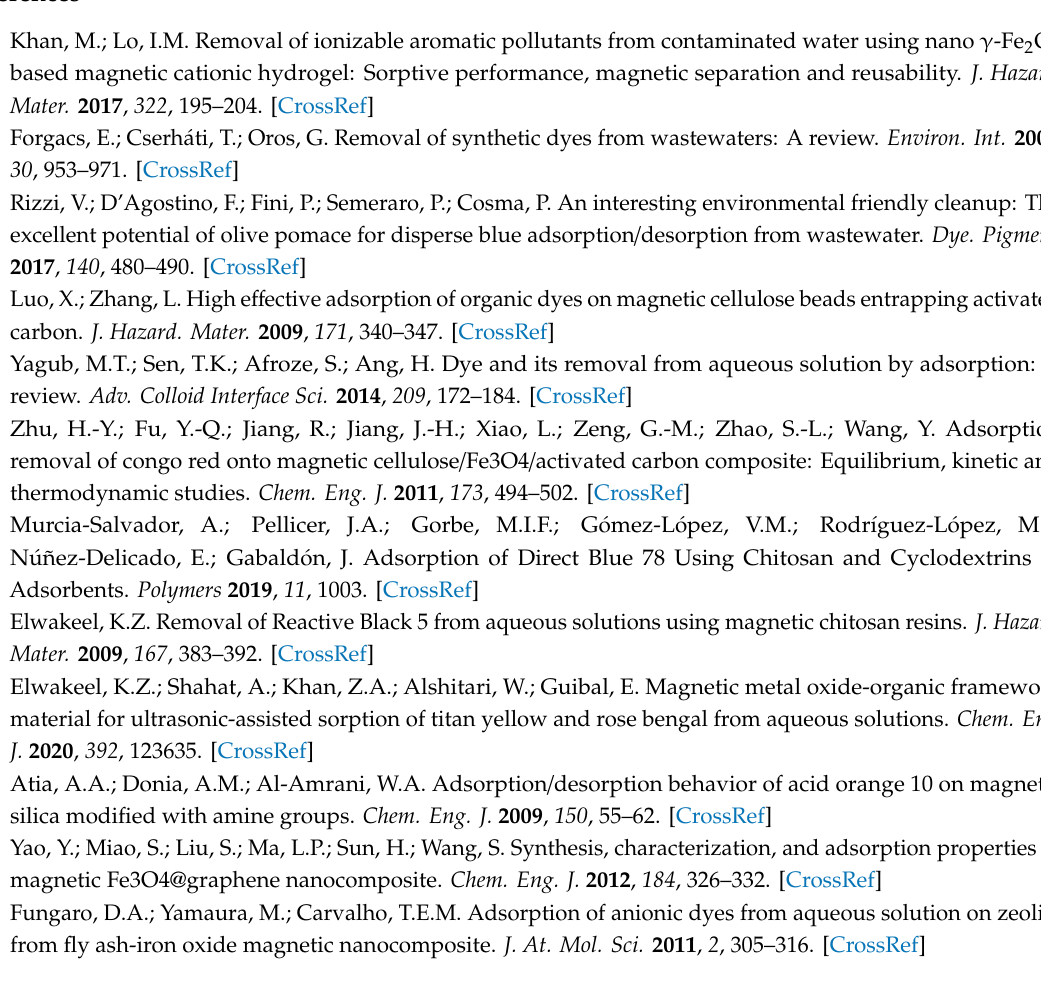
Figure S1: 1H NMR spectra of γ –CD, HP– γ –CD, γ – and HP– γ –CD EPI